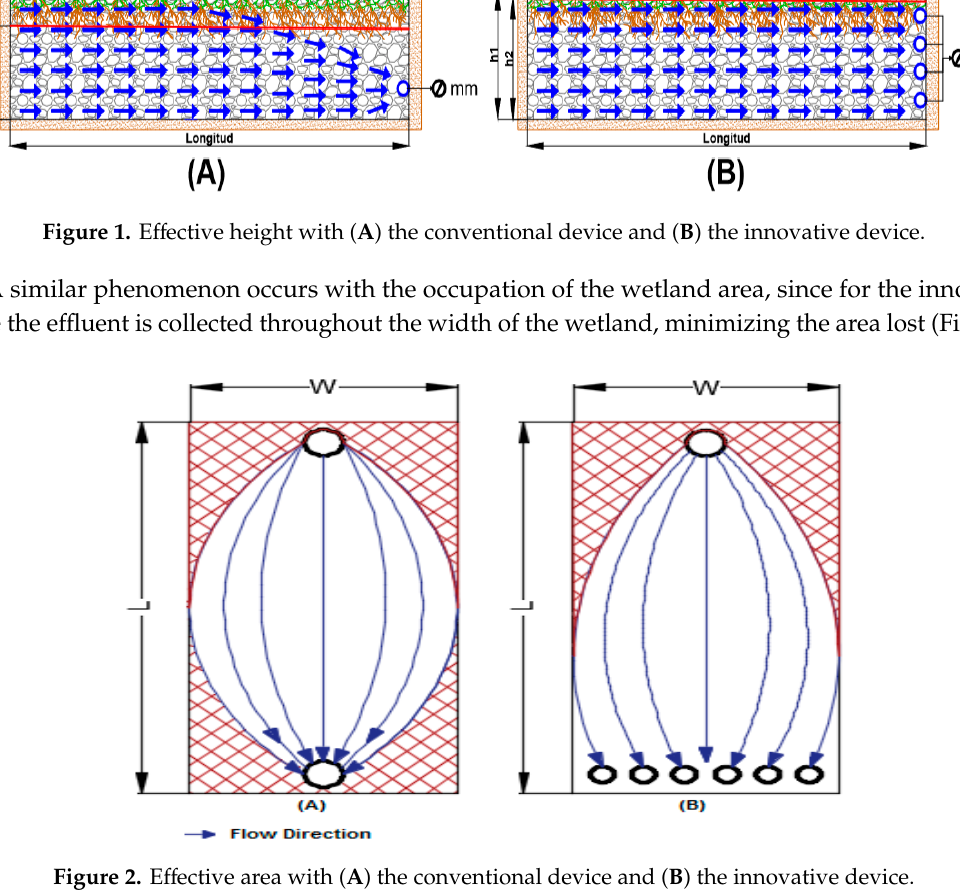
Figure 2. Effective area with ( A ) the conventional device and ( B ) the innovative device.